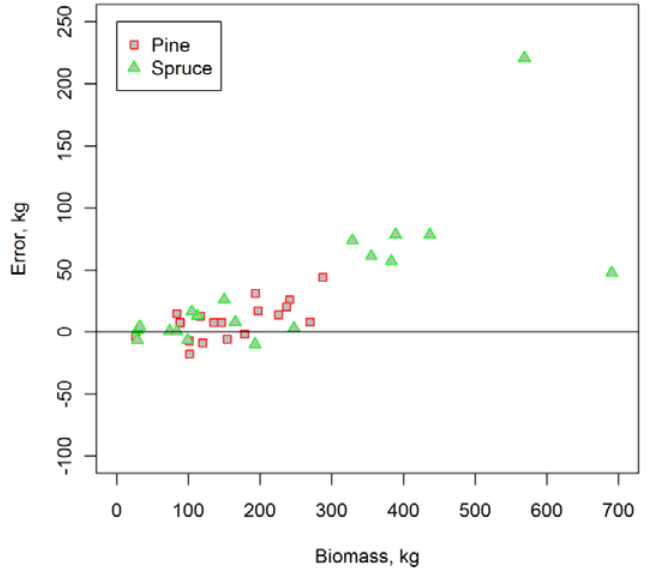
Figure 4. Residual plot for AGB at tree level. AGB prediction error in kg is presented in y-axis for Scots pine (red) and for Norway spruce